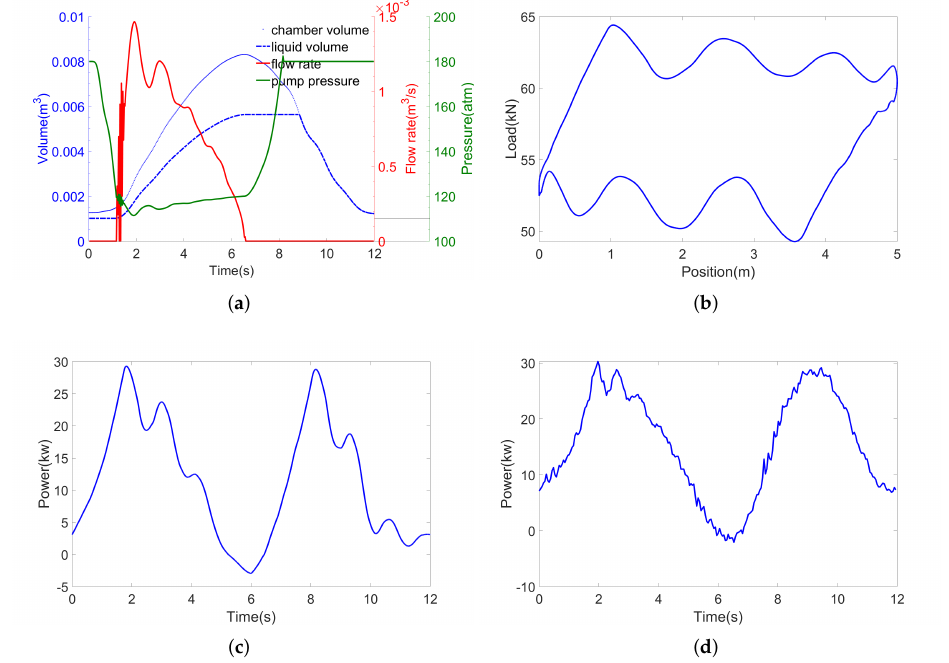
Figure 6. Normal working state. ( a ) Pump simulation. ( b ) Generated DC. ( c ) Generated MPC. ( d ) Actual